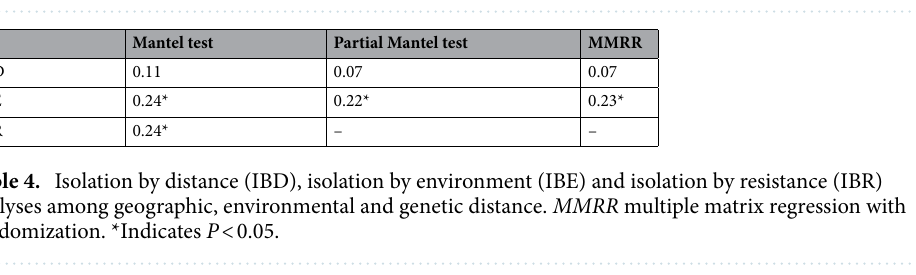
IBD, IBE and IBR analyses. The environmental and geographic distance show weak correlation ( r = 0.21). Based on geographic, environmental and genetic distance, Mantel test and partial Mantel test show significant IBE ( r = 0.24, P = 0.03), or ( r = 0.23, P = 0.04) when accounting for geographic distance, while no significant IBD ( r = 0.11, P = 0.08), or ( r = 0.07, P = 0.20) when accounting for environmental distance (Table 4, Supplementary Fig. S5). The multiple matrix regression with randomization (MMRR) also indicates significant IBE ( r = 0.23, P = 0.04) while not IBD ( r = 0.07, P = 0.38). Mantel test further shows significant IBR ( r = 0.24, P = 0.03). The first two axes of the principal component analysis, PCA, on climate data for the investigated populations